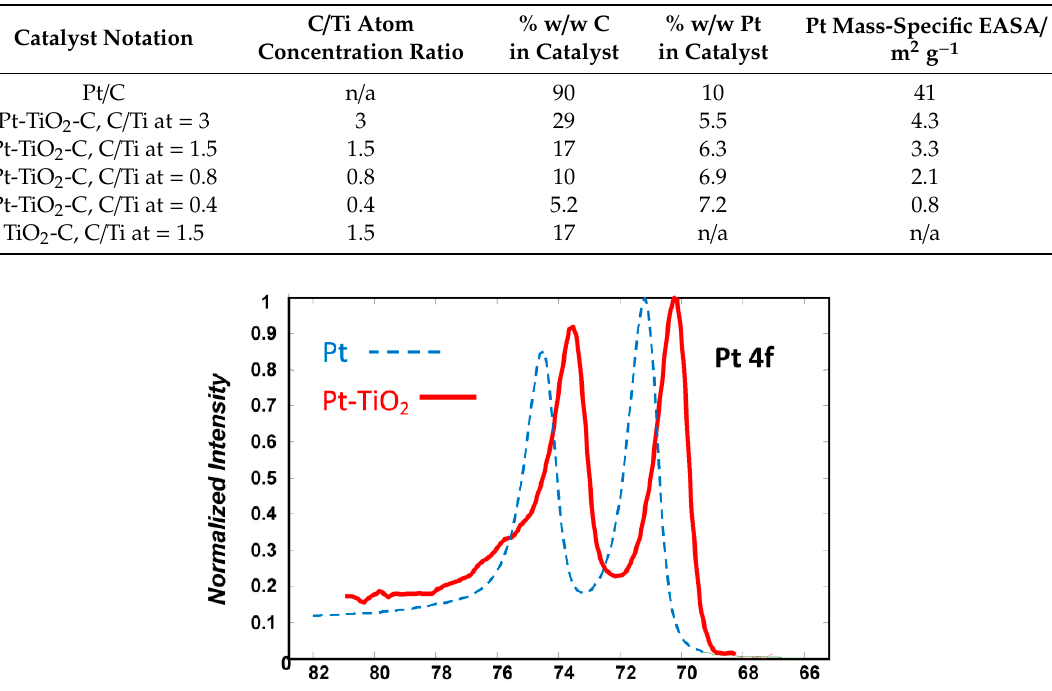
Figure 1. ( A–E ) HR-TEM micrographs of a Pt-TiO 2 catalyst prepared by Pt photodeposition on TiO 2 Degussa P-25 ® nanoparticles, at various magnifications (as indicated by the scale bars) and locations, depicting: ( A ) the overall catalyst picture, ( B ) large Pt aggregates and ( C–E ) individual Pt nanoparticles). ( F ) SAED diffractogram of the area shown in ( D ) with catalyst crystal structures. Table 1. Catalytic electrode specifications with respect to notation, composition and Pt mass-specific electroactive surface area, EASA (as determined from CO electro-desorption experiments).